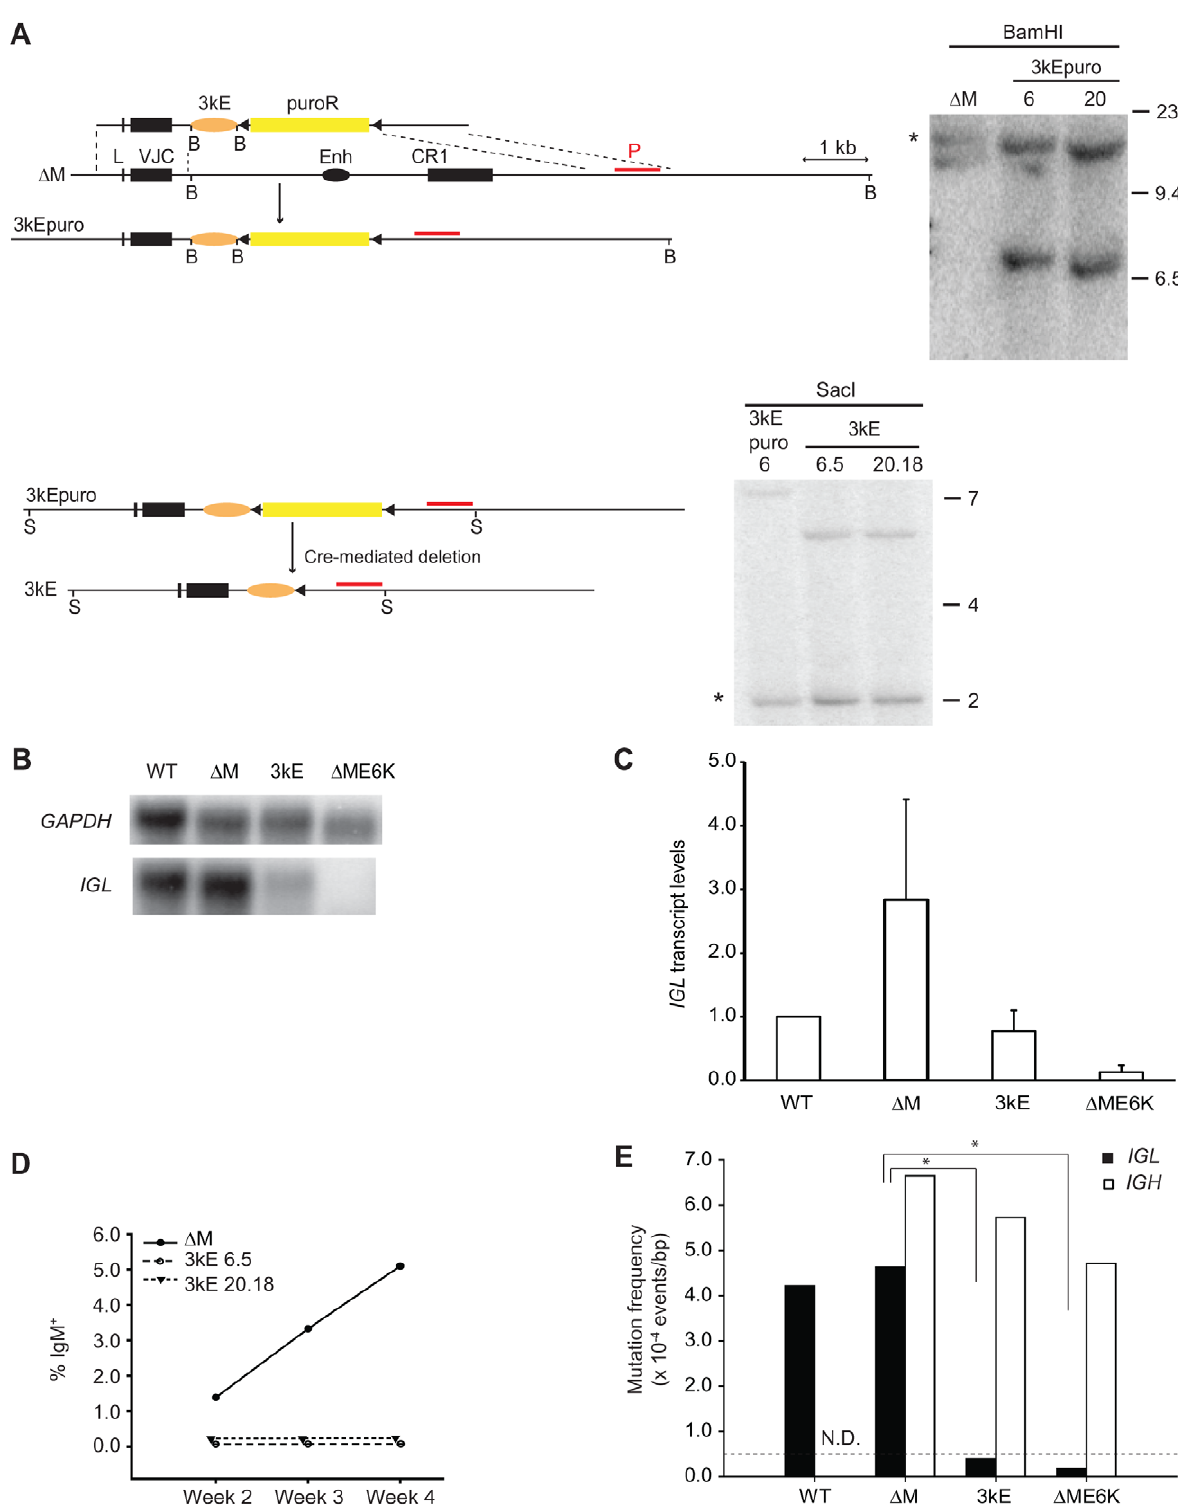
Figure 3. Functional analysis of the 3 9 E enhancer element. A) Gene-targeting scheme to generate the 3kE DT40 knock-in cell lines. The 3kE element is represented as an orange oval, the restriction sites used for Southern Blot analyses are marked (B: BamHI, and S: SacI), and the Southern blot probe (red line, P) used for genotyping is shown. For a description of all other elements, see legend to Fig. 1. The asterisk in each Southern blot marks the band that originates from the non-rearranged allele. B) Northern Blots were run using 10 m g of total RNA of wild-type (WT) DT40 cells and each of the indicated cell lines, and hybridized sequentially with IGL and GAPDH probes. One representative example is shown. C) Average normalized steady-state transcript levels of IGL measured by Northern blot analyses obtained from at least four independent values per genotype. The value for wild-type (WT) DT40 cells is arbitrarily set to one. D) GCV was quantified by flow cytometry over four weeks starting from single cell